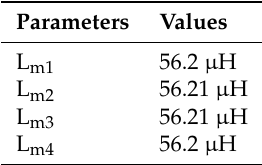
Table 2. Magnetizing inductance ratio for each of the secondary